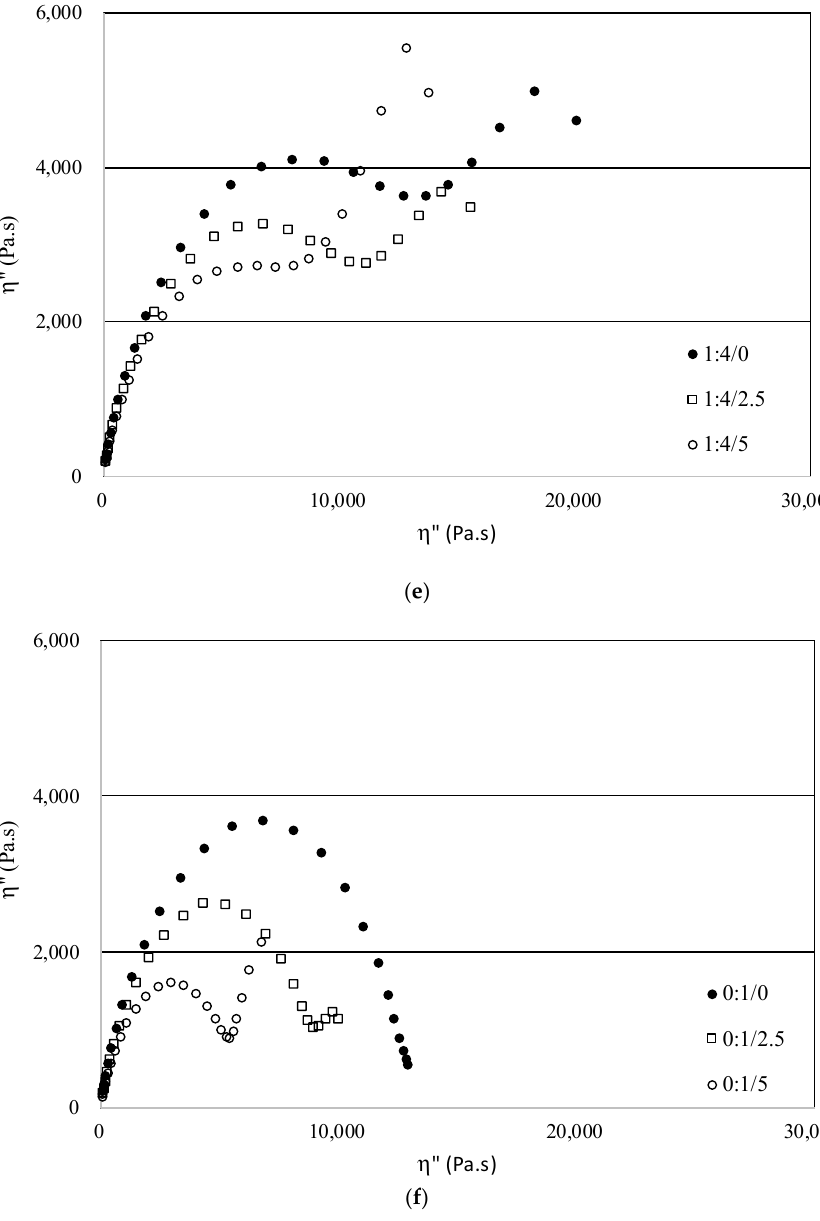
Figure 20. Cole-Cole plots of PP/HIPS blends ( a ) 1:0; ( b ) 4:1; ( c ) 3:2; ( d ) 2:3; ( e ) 1:4 and ( f ) 0:1, with different CNSL contents.